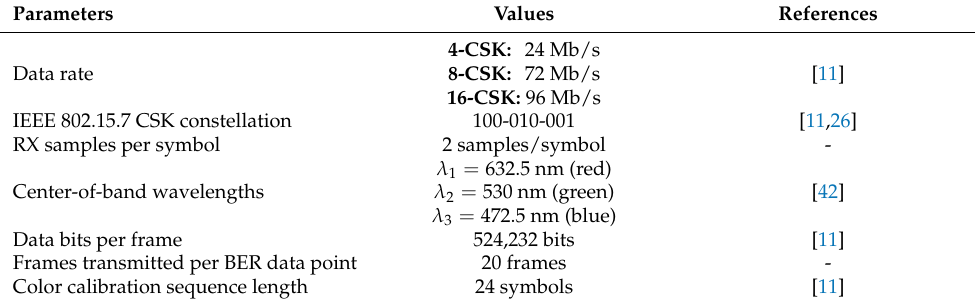
Table 3. BER simulation